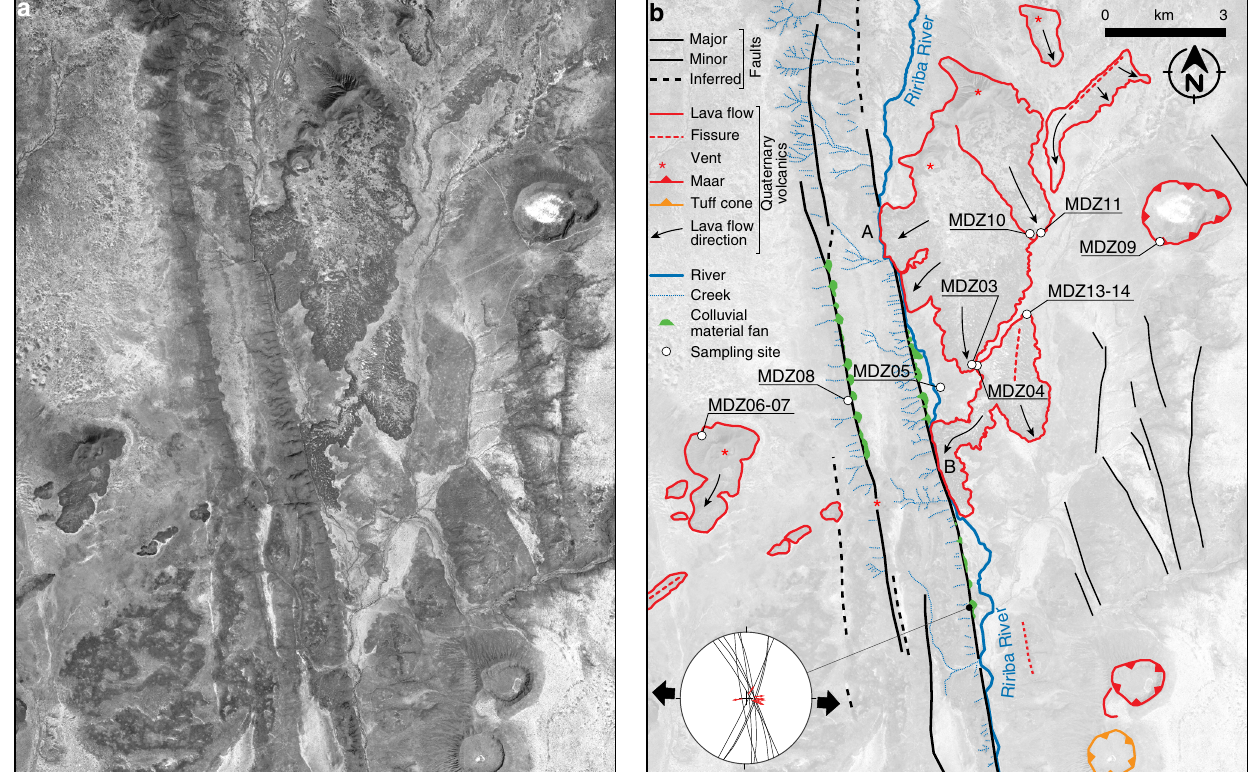
Fig. 3 Quaternary volcanic features, faults and morphotectonic elements of the central part of the Ririba rift. Satellite image (courtesy of the DigitalGlobe Foundation) ( a ) and line drawing of Quaternary volcanic features, faults and morphotectonic elements ( b ). Letters A and B denote locations discussed in the text. Plot in the bottom left corner shows stereographic projections (Wulff net, lower hemisphere) of the fault planes and the collected associated fault- slip vectors (from the station of structural measurements indicated with the black dot); black arrows indicate the direction of extension obtained by using the P&T axes inversion method calculated with Win-Tensor